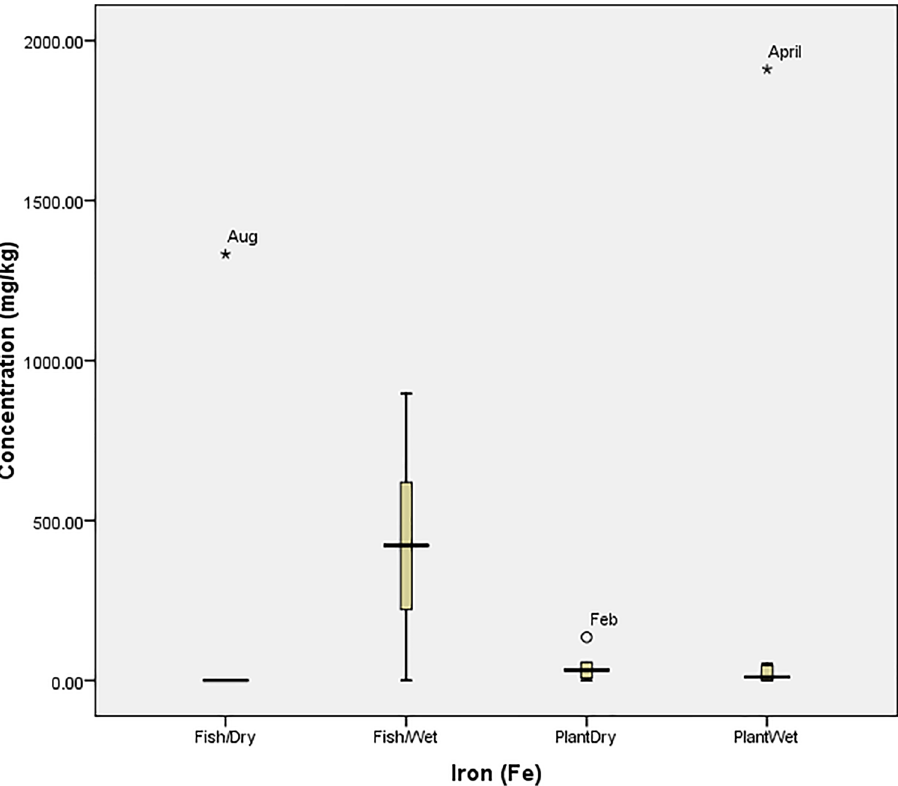
Figure 5. Tolerability of Iron (Fe) in O. niloticus (Fish) and I. aquatica (Plant) in Wet and Dry Seasons (Source: Field